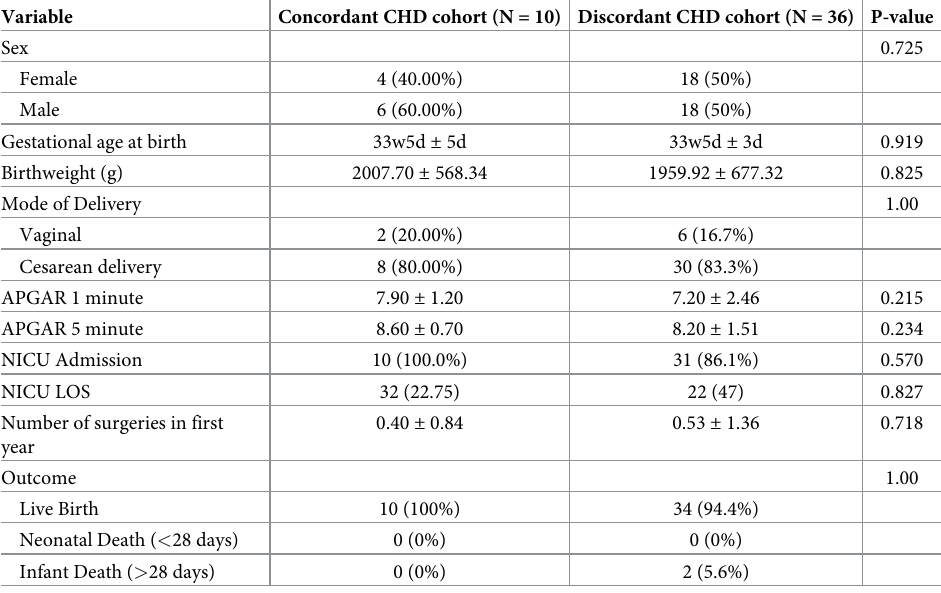
Table 6. Neonatal outcomes and clinical details in concordant and discordant CHD groups. Variable